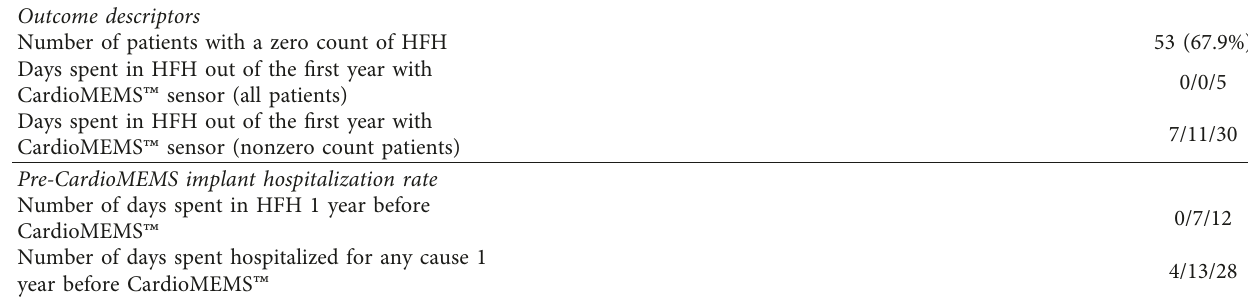
Table 3: Heart failure hospitalization statistics.